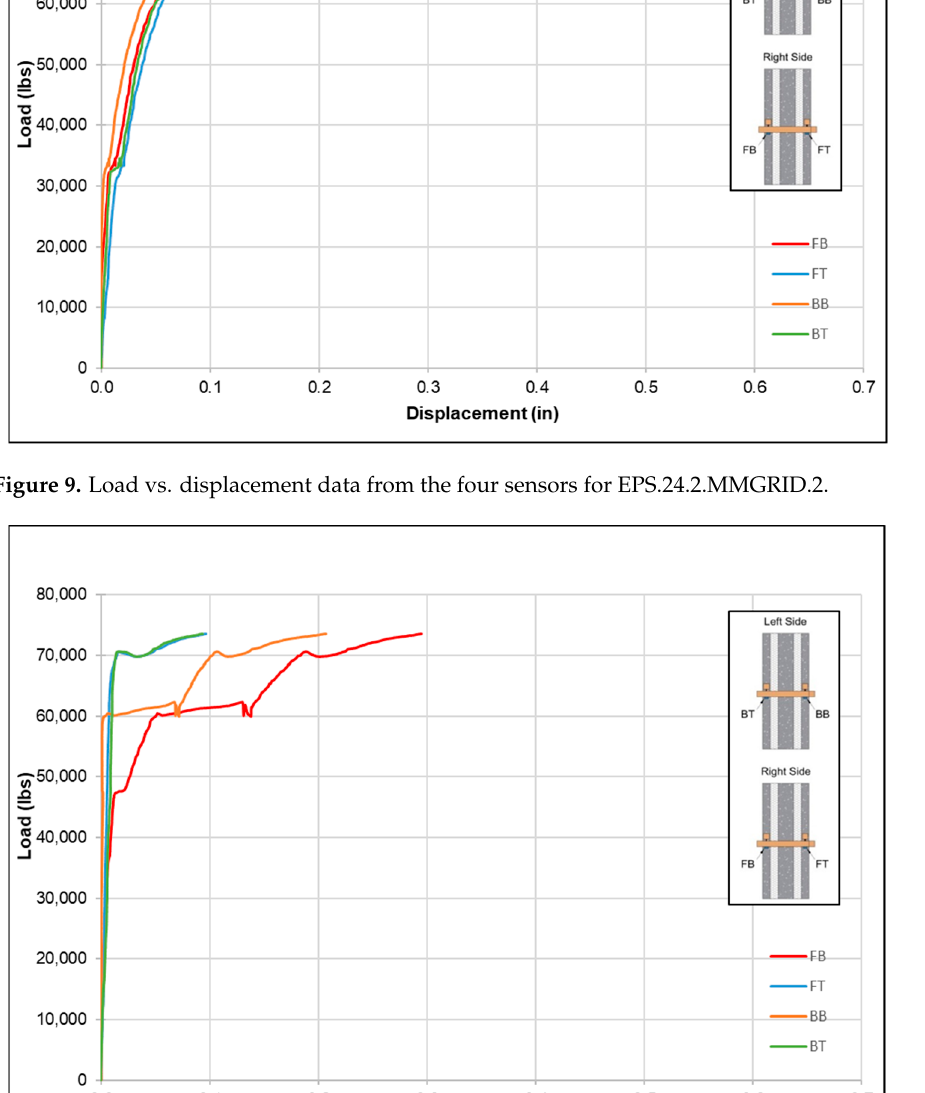
Figure 10. Load vs. displacement data from the four sensors for EPS.24.2.MMGRID.3.